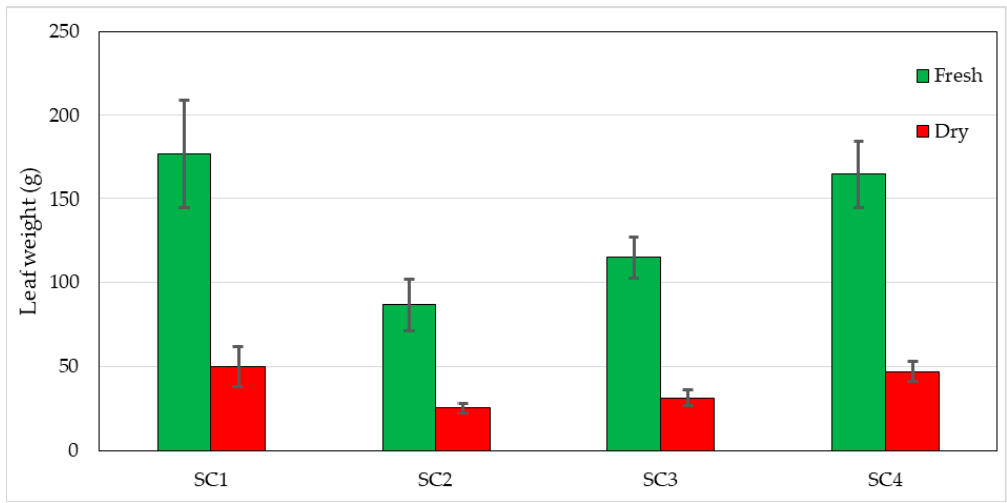
Figure 7. Mean values of fresh and dry leaf weight (expressed as g/potted plant) related to the four Substrate Compositions (SC). The bars stand for standard deviation values ( n = 4).